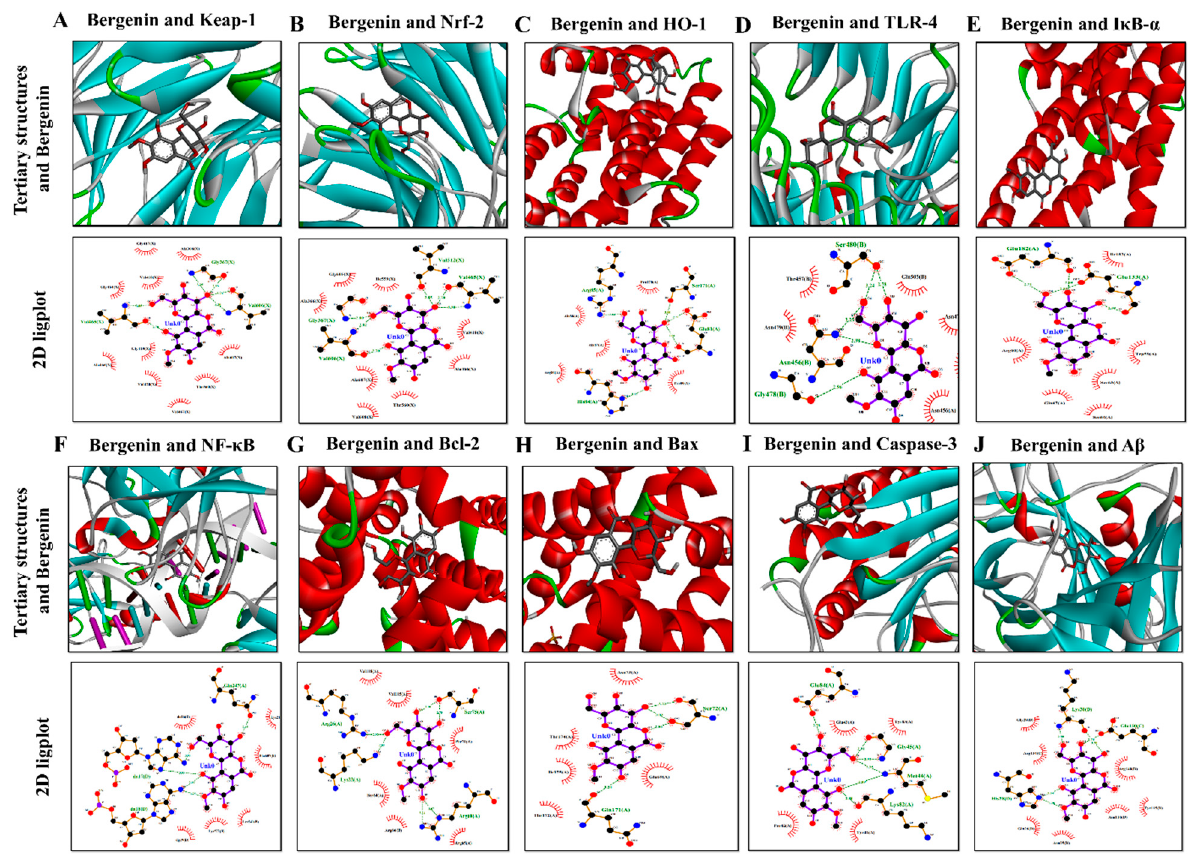
Figure 14. Representation of 3D (three dimensional) tertiary structure of protein with ligand and 2D (two dimensional) Ligplot structural interaction of ligand (Bergenin) with target proteins, i.e., ( A ) Keap1, ( B ) Nrf-2, ( C ) HO-1, ( D ) TLR-4, ( E ) I κ B- α , ( F ) NF- κ B, ( G ) Bcl-2, ( H ) Bax, ( I ) Casp-3 and ( J ) A β .